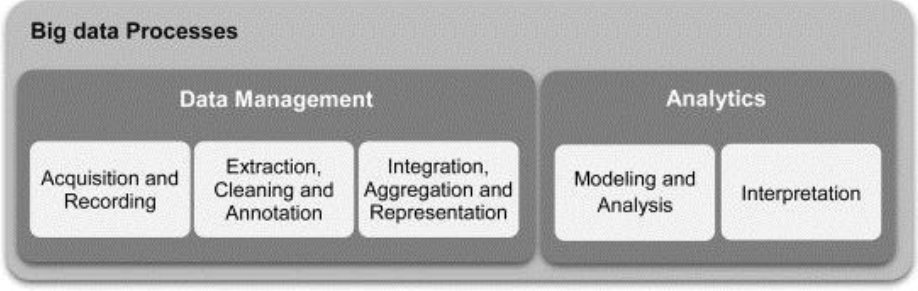
Figure 1. Big data processes (Labrinidis and Jagadish,